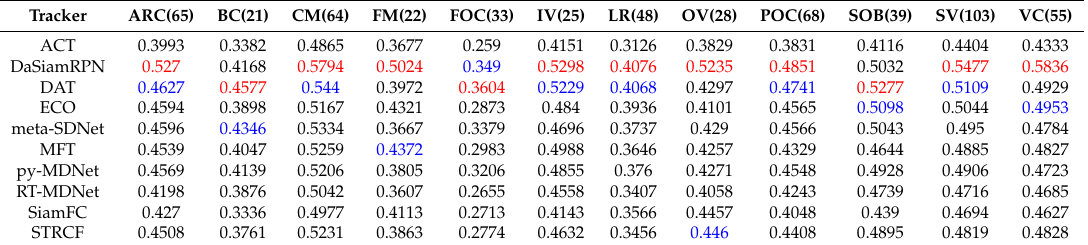
Table 4. Overlap results for various UAV123 dataset attributes listed in Table 1. Top performing tracker is shown in red and the second best performer is shown in blue. Best viewed in color. Tracker